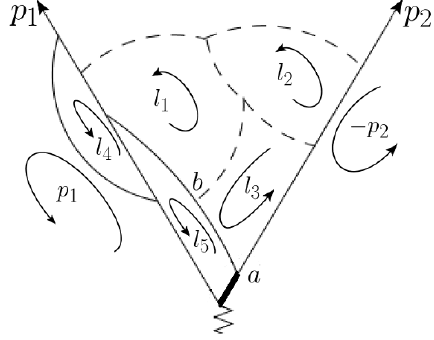
Figure 20. The way we mark the loop momenta of A .